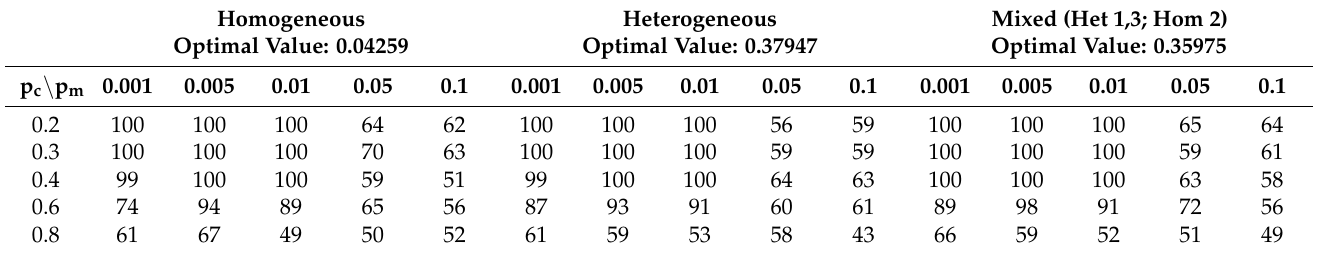
Table 7. Simulation results of crossover and mutation probabilities.